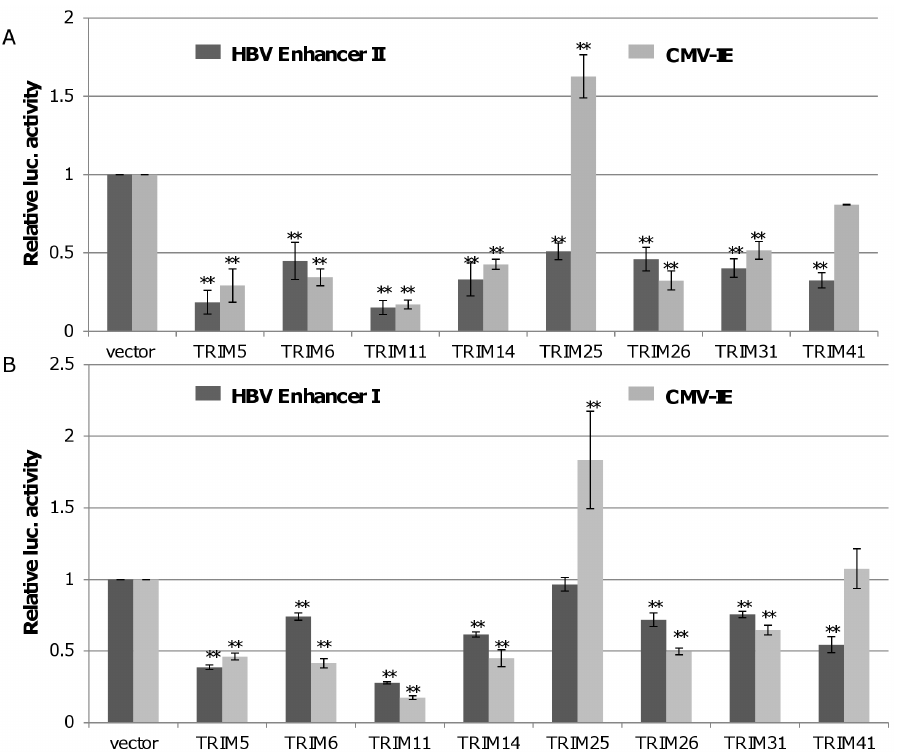
Figure 3. Effects of the eight TRIM proteins on HBV Enhancer I and Enhancer II activity in HepG2 cells. 0.2 m g of pGL4.10-HBV Enh II or pGL4.10-HBV Enh I was co-transfected into HepG2 cells in 24 well plates with 0.2 m g of a vector plasmid or a plasmid expressing an indicated TRIM protein, with 0.1 m g of pCMV-renilla luciferase as an internal control. After two days post transfection, cells were harvested and the luciferase activity was analyzed with a dual-luciferase kit. The mean and standard deviations (n=4) were presented. * and ** indicate P , 0.05 and 0.01, respectively.